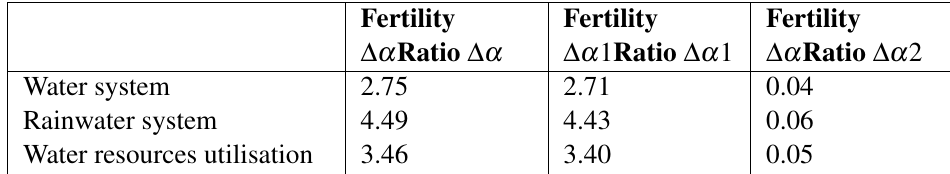
Table 5 Cost-earnings